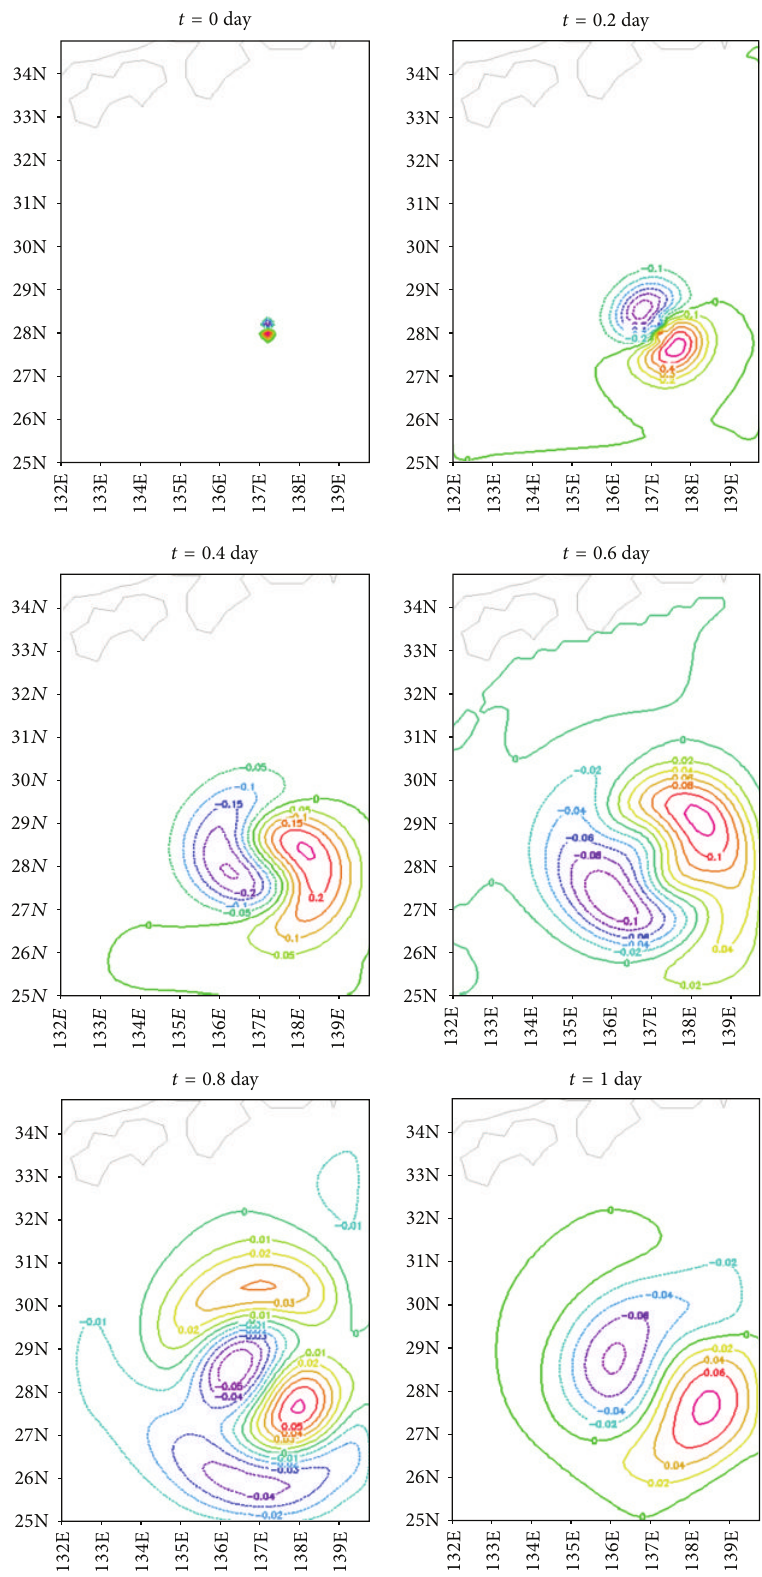
Figure 7: The figures show the meridional velocity of the ocean current throughout a period of the time-dependent solution that evolves in one